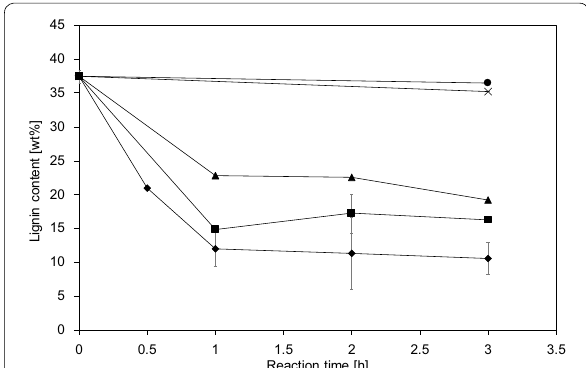
Fig. 1 Change in lignin content of Japanese cedar with treatment time for different concentrations of sodium oleate or sodium acetate in glycerol at different temperatures. Error bars shows standard deviation ( n 3). Symbols: times, glycerol only; filled circle, 5% C 18:1 Na = at 250 °C; filled square, 10% C 18:1 Na at 250 °C; filled rhombus, 20% C 18:1 Na at 250 °C; filled traingle, 20% C 18:1 Na at 230 °C. Fatty acid sodium soaps are defined in Table